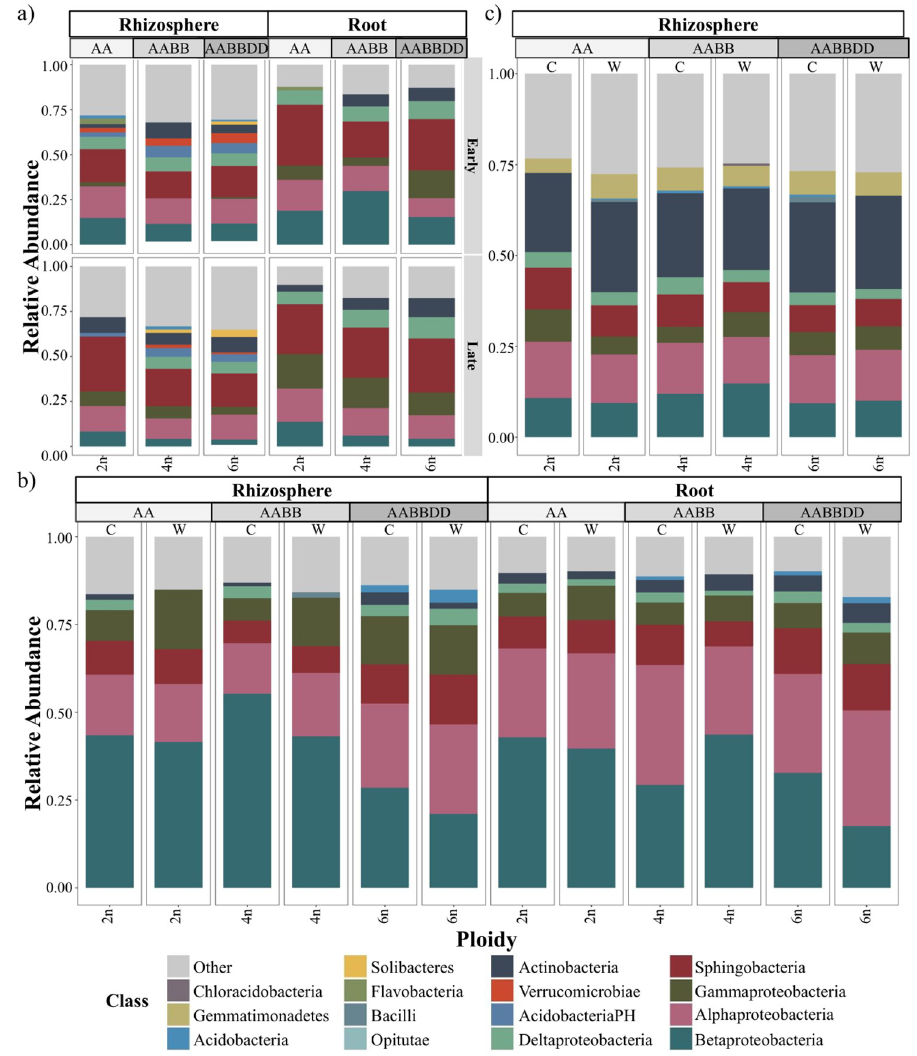
Fig 4. Ploidy level and domestication status correspond to compositional shifts in the 2015 field and 2017 greenhouse studies. Stacked bar plots of class-level relative abundances for wheat bacterial communities sampled in the 2015 field study from rhizospheres and roots (a), greenhouse study from rhizosphere and roots (b), and 2017 field study from rhizospheres (c). Genome lineage is denoted by ‘AA’, ‘AABB’, and ‘AABBDD’; ‘C’ denotes the bacterial community is from a cultivated genotype, ‘W’ from a wild